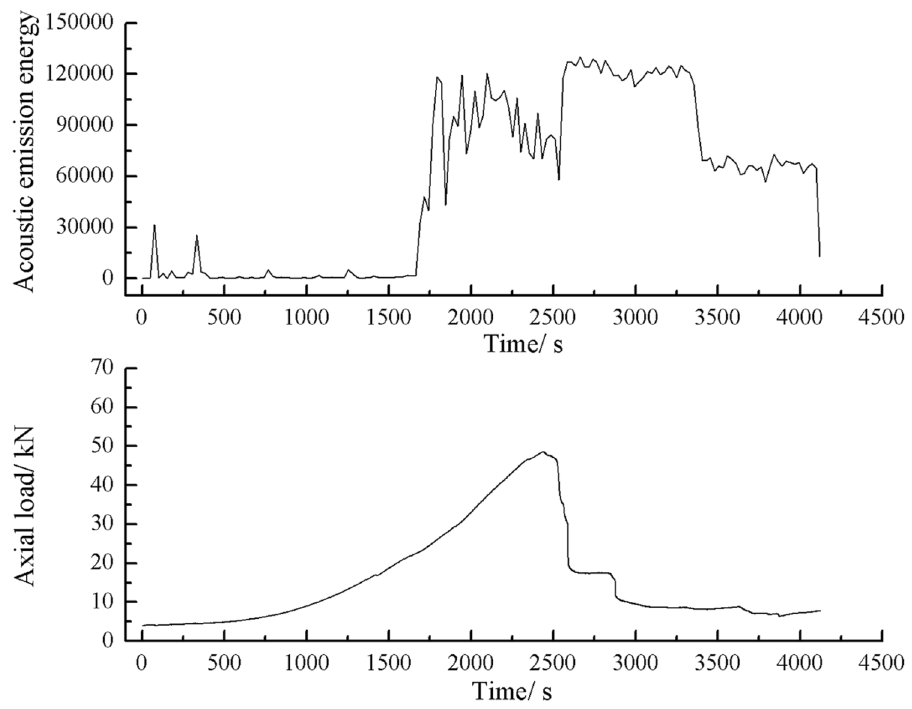
Figure 63. Acoustic emission energy-Axial load curve of the rock mass comprised of one grain size range.